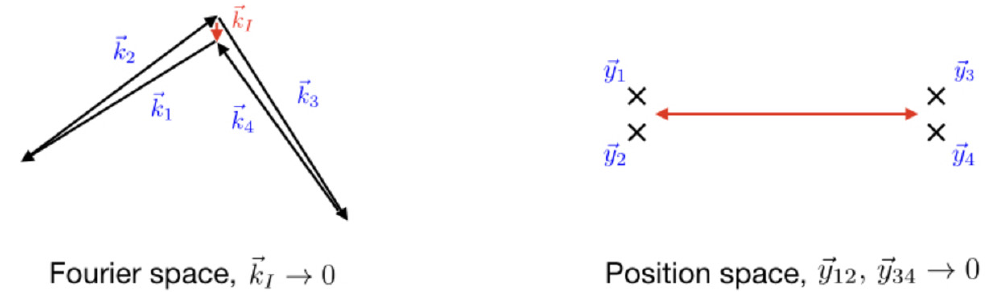
Figure 8. Left: con(cid:12)guration of momenta in the OPE (collapsed) limit k I ! 0 for exchange four-point functions, where ~k I = ~k 1 + ~k 2 . Right: in position space this corresponds to the points forming two pairs which are separated far from each